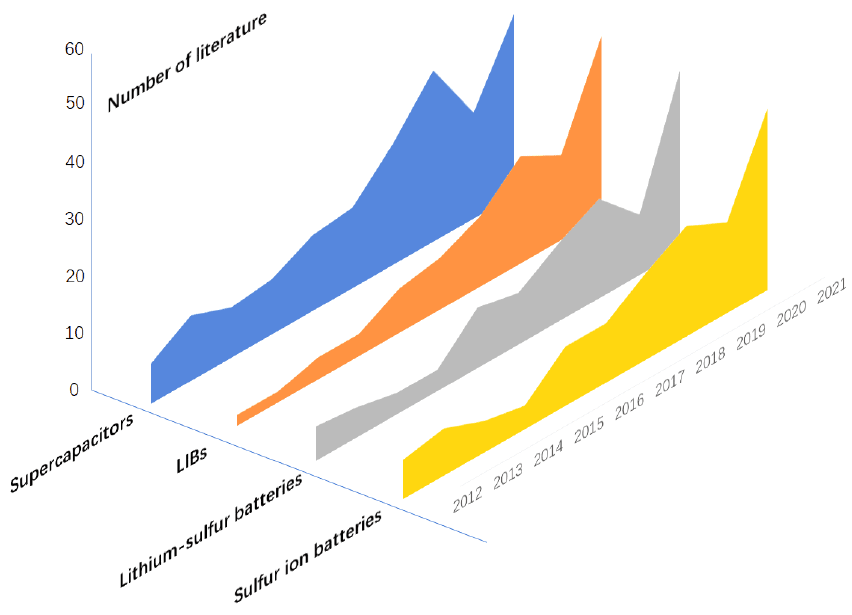
Figure 13. Research situation of CSs in LIBs, Lithium-sulfur batteries and Sulfur ion batteries from 2012 to 2021.